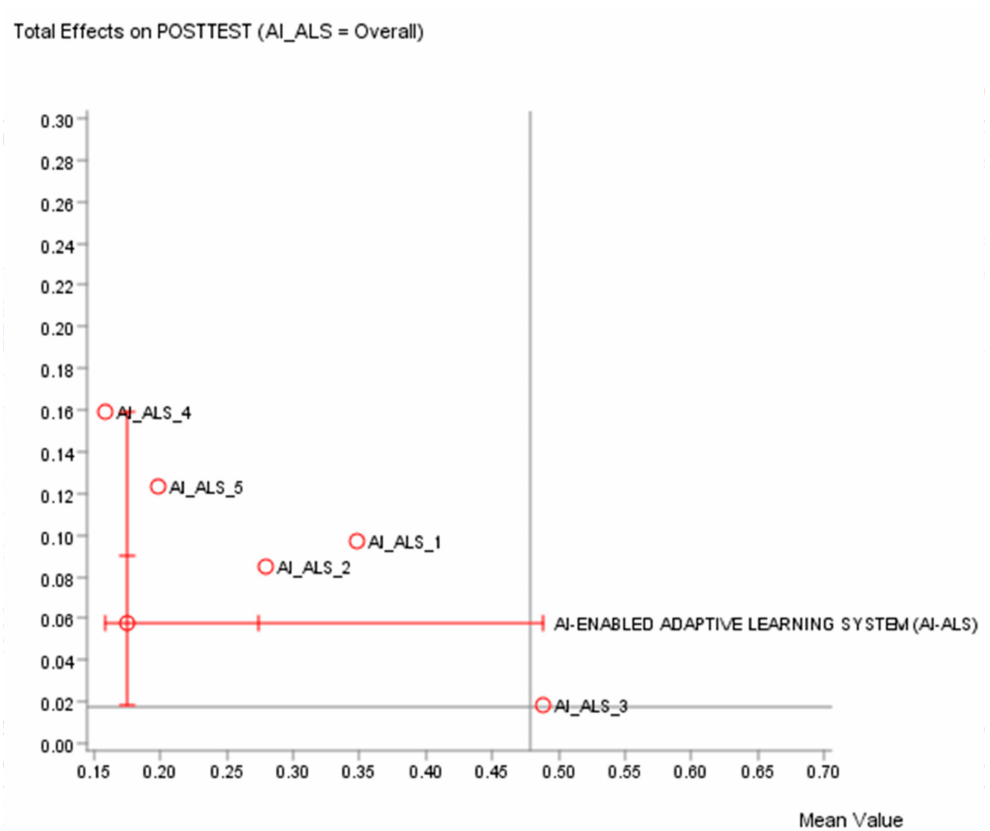
Figure 5. Comparison of Total E ff ects of the five di ff erent AI-ALS on the Post-test, which was machine-learned and generated by